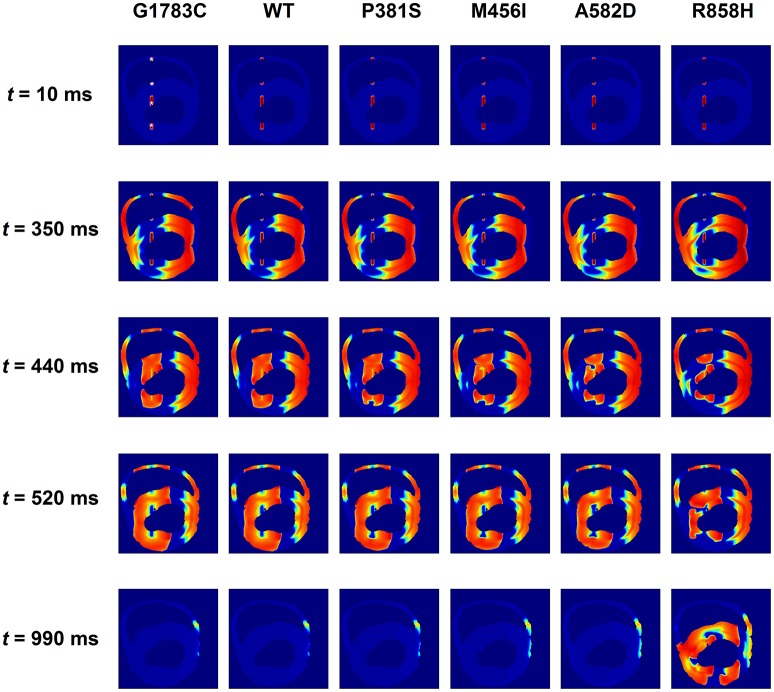
Snapshots of transmural conduction of electrical waves in a transmural ventricular slice. Electrical waves were elicited by the S1 stimulus applied to four endocardial (ENDO) sites (marked with white asterisks). Snapshot taken at t = 10 ms. Another S1 stimulus applied to the same sites at t = 350 ms generated several electrical waves. Action potential propagation under G1783C and wild-type (WT) conditions, local conduction block under P381S, M456I, and A582D conditions, and unidirectional conduction block under the R858H condition. Snapshot taken at t = 440 ms. Several spiral waves developed at t = 520 ms and sustained excitation waves at t = 990 ms under the R858H condition.